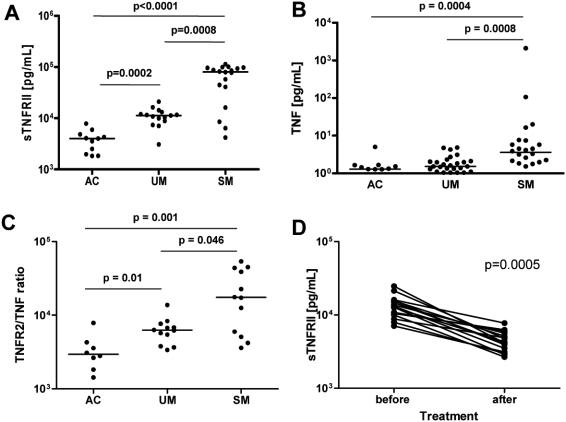
Elevated soluble TNFRII in malaria is associated with disease severity.(A) Plasma levels of soluble TNFRII were elevated in malaria with significant differences between AC, UM, and SM patients. (B) Plasma TNF levels in AC, UM, and SM patients. (C) The ratio of plasma levels of sTNFRII to TNF in AC, UM, and SM patients. (D) In UM, soluble TNFRII levels decreased in convalescence (p = 0.0005; Wilcoxon-rank test). AC, malaria-exposed asymptomatic controls; UM, uncomplicated P. falciparum malaria; SM, Severe P. falciparum malaria.